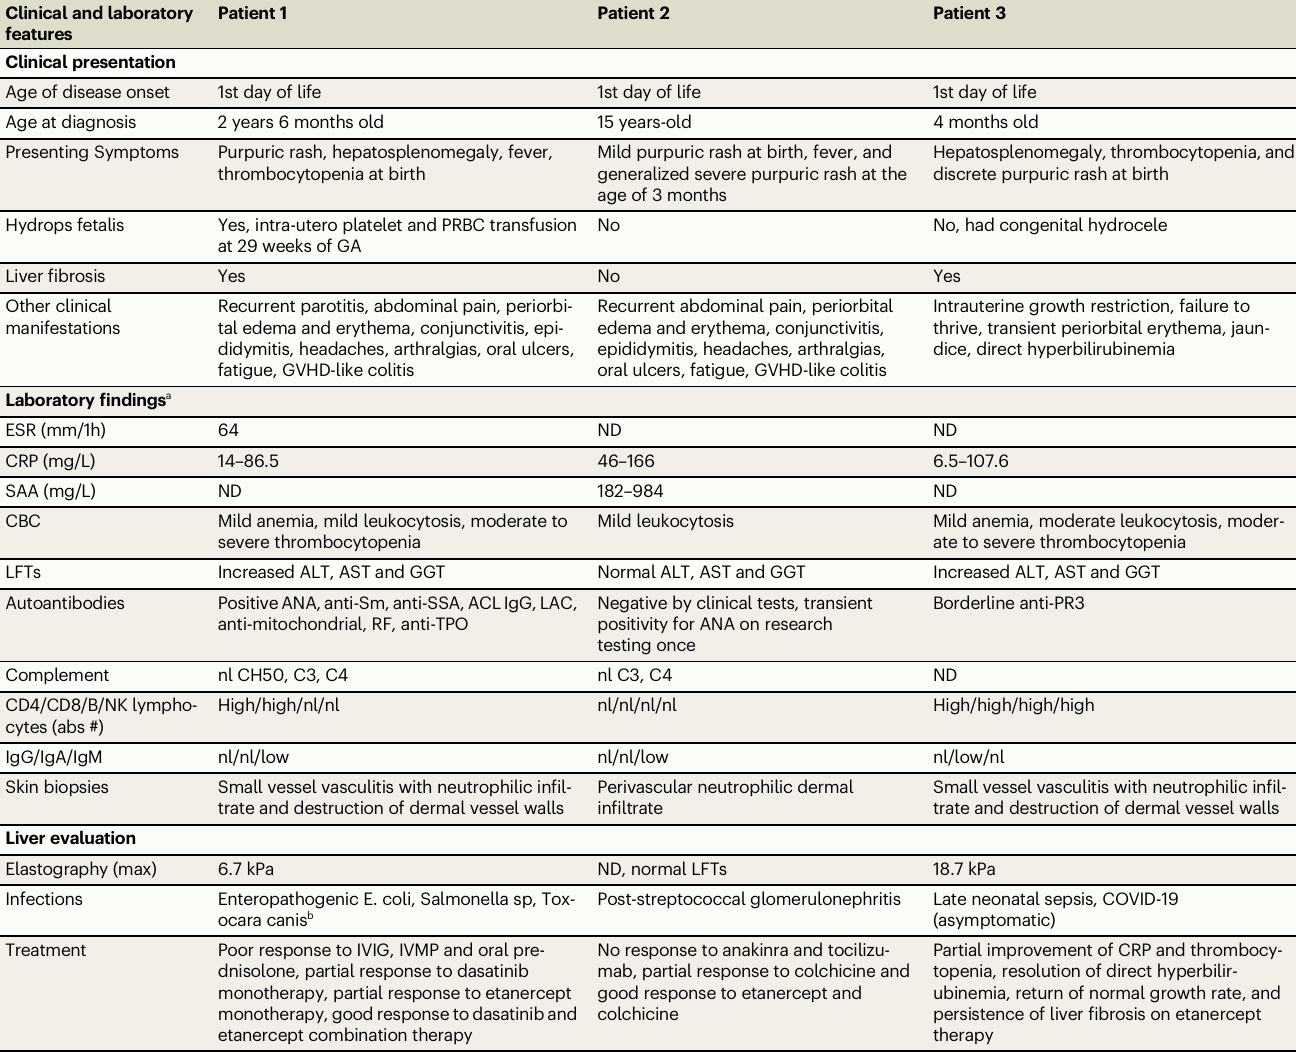
Table 1 | Clinical features in patients with gain-of-function mutations in LYN Clinical and laboratory